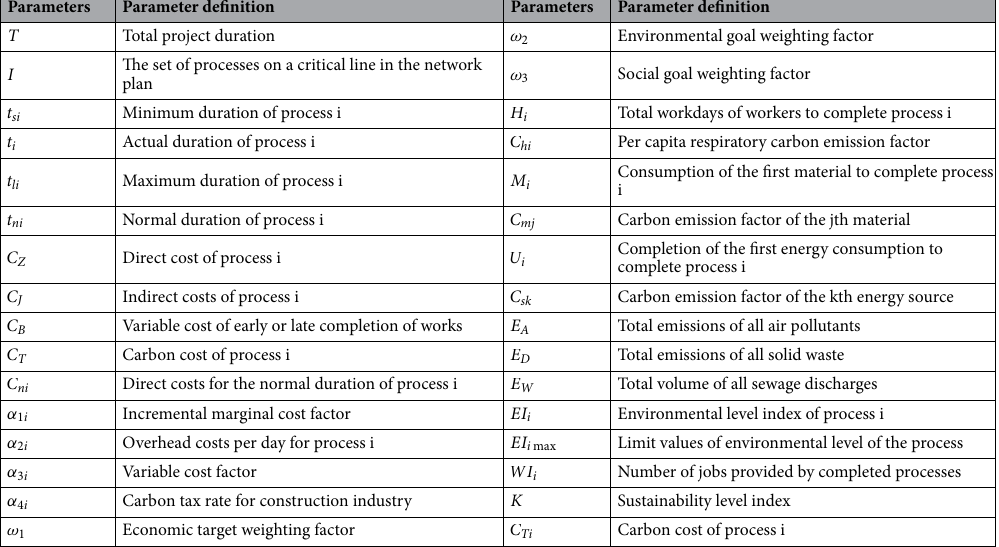
Table 1. Parameter